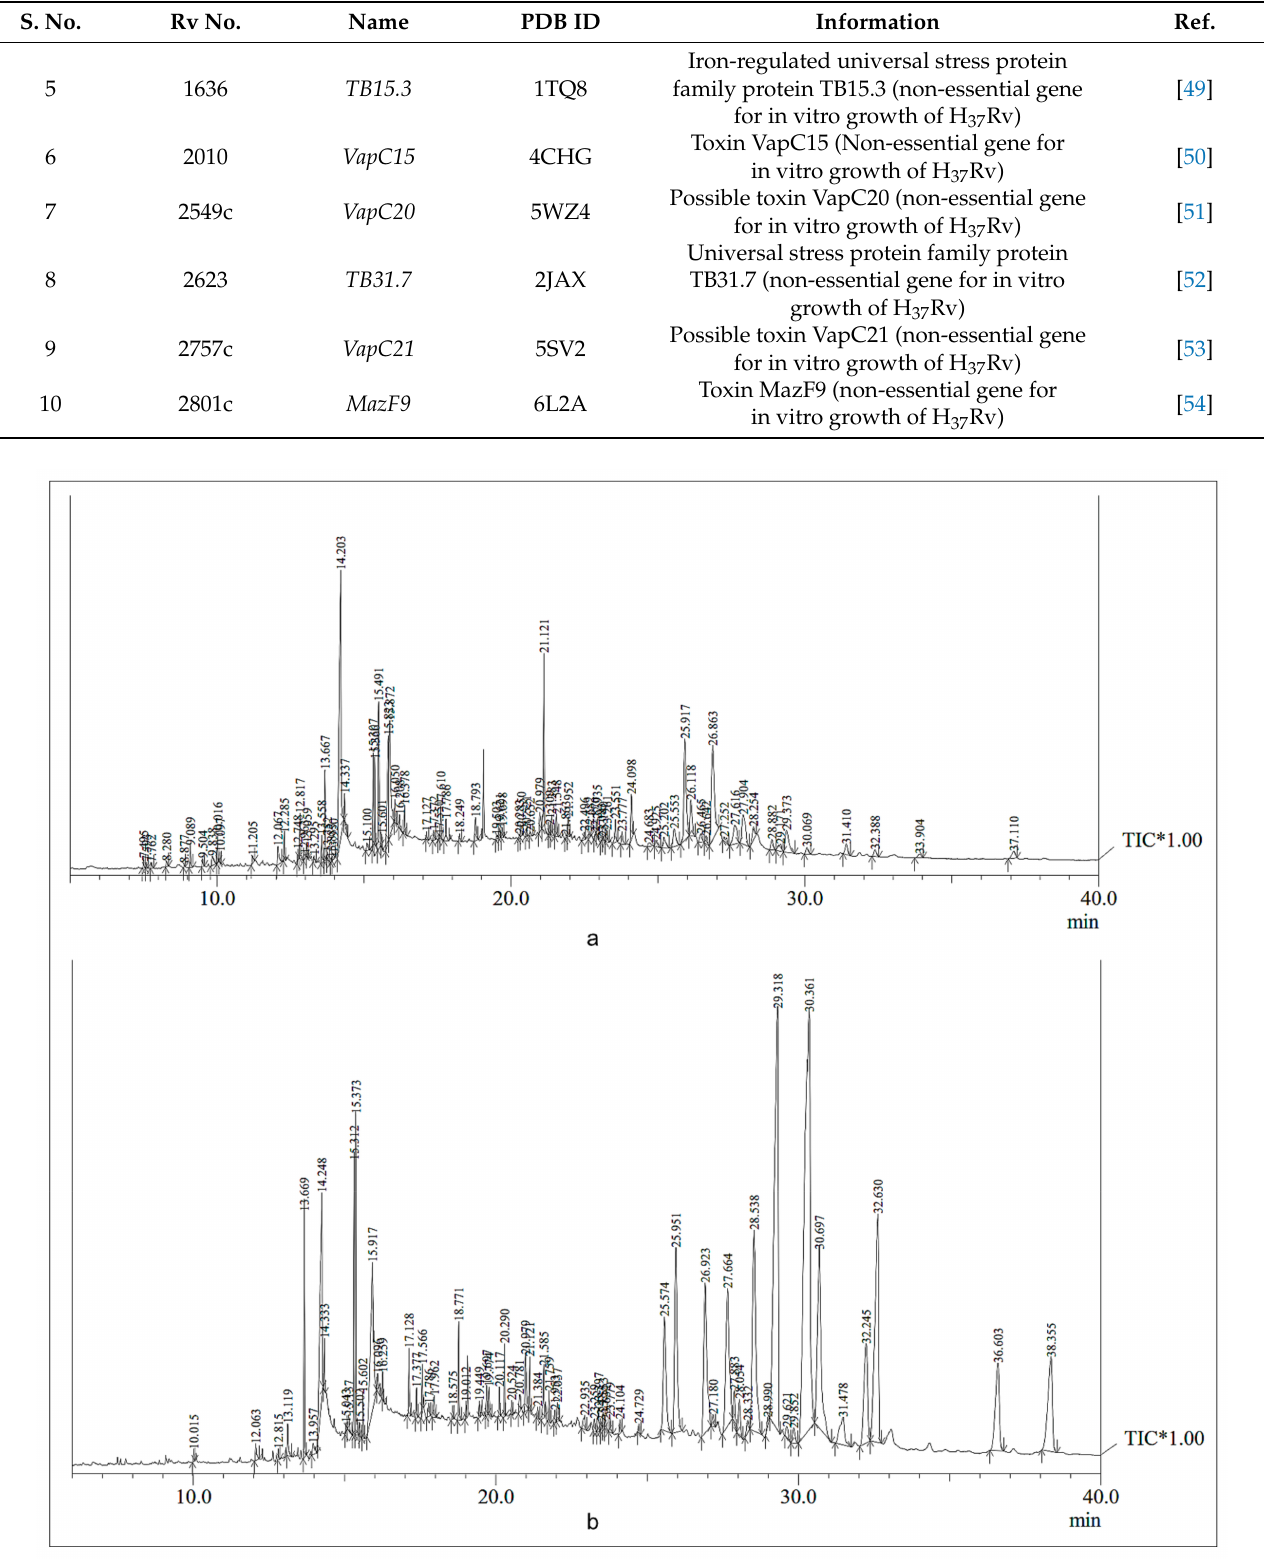
Figure 3. GC-MS chromatogram of ethyl acetate fractions of ( a ) A. aspera (aerial) and ( b ) C. gigantea (flower ash). TIC* indicates Total Ion